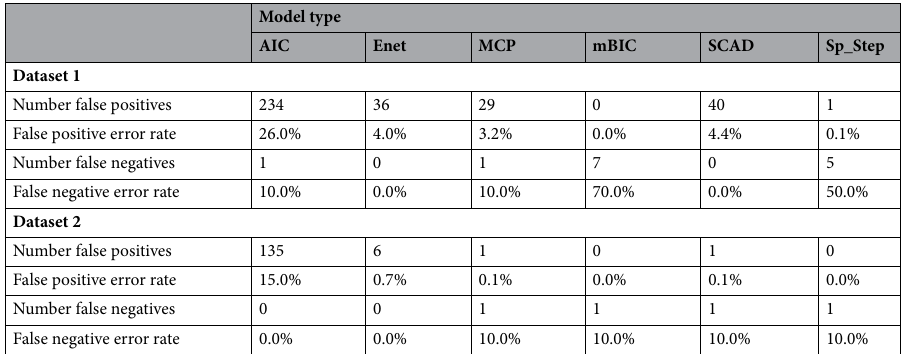
Table 1. Error rates in variable selection of six statistical methods conducted on two simulated datasets. Datasets 1 and 2 both contained 1000 observations and 910 potential explanatory covariates of which 10 were simulated to be ‘correct’ covariates and calculated to have a true effect on the outcome. The true covariates in Dataset 1 explained 28% of the variability in outcome and those in Dataset 2 explained 73%. AIC Stepwise selection based on Akaike Information Criterion, Enet elastic net regression, MCP minimax convex penalty, mBIC modified Bayesian Information Criterion, SCAD smoothly clipped absolute deviation, Sp_Step SparseStep